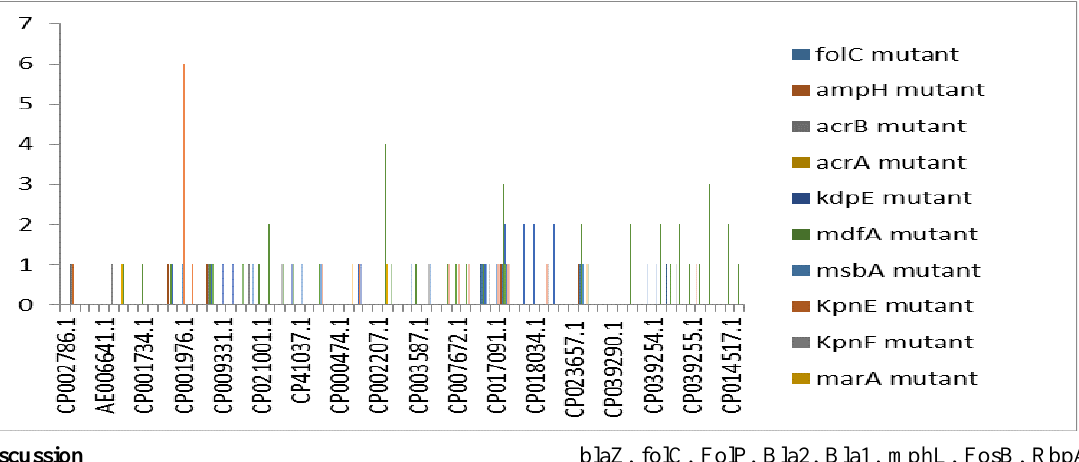
Figure 5. Resistant genes categorized under ‘strict’ in all the 30 complete genome sequences